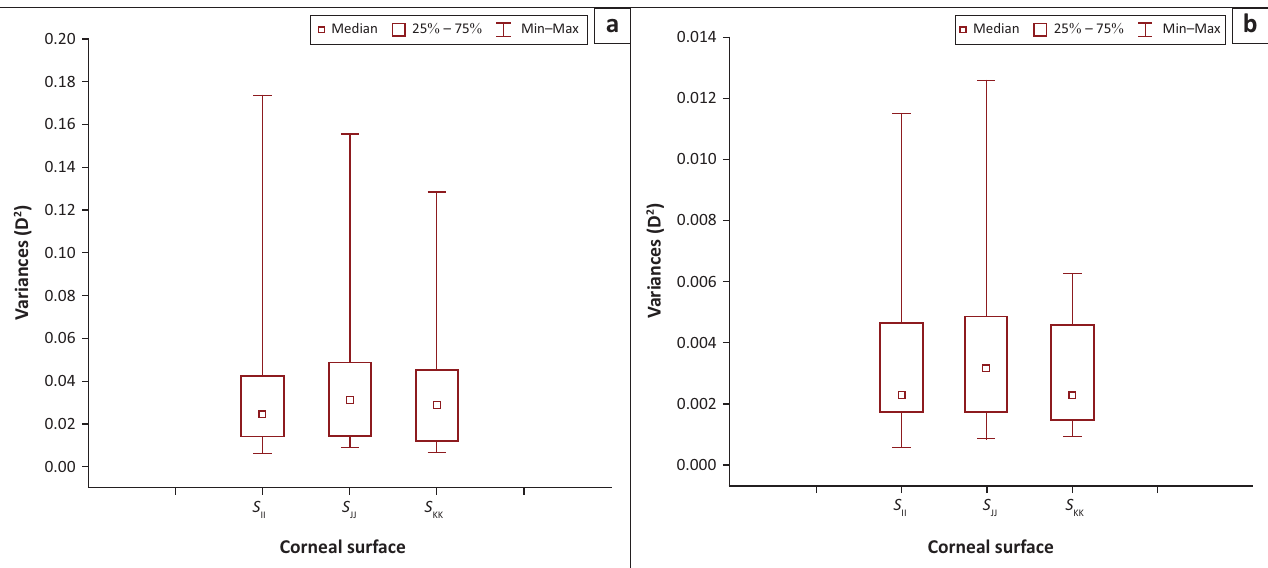
, S and S are the II JJ KK